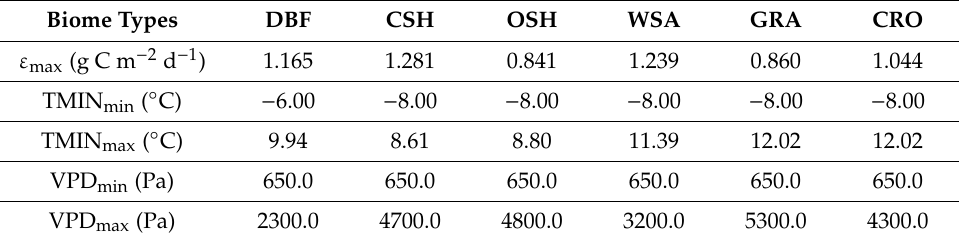
Table 2. Biome properties lookup table for the MODIS GPP